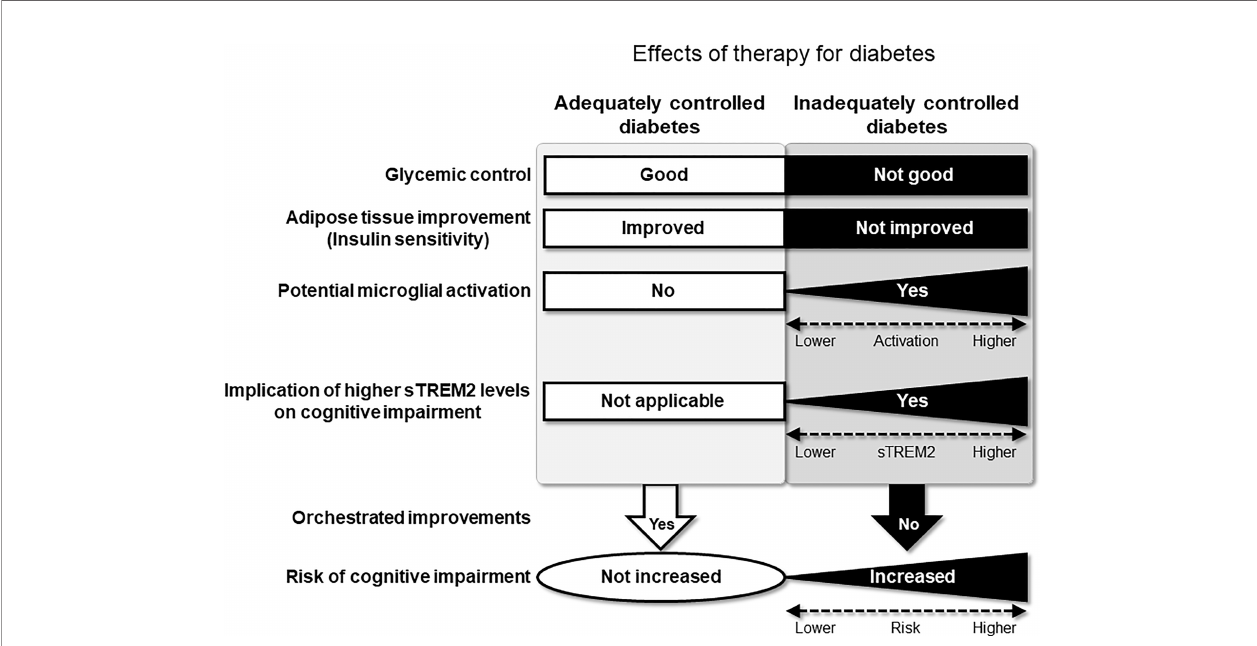
FIGURE 3 | Hypothetical pathological relationships exist between sTREM2 levels, diabetes-related parameters, and cognitive impairment in patients with type 2 diabetes without obesity. Effective therapy for diabetes will allow the orchestrated improvement of risk factors for cognitive impairment. Conversely, in inadequately controlled type 2 diabetes without obesity, sTREM2 derived from the adipose tissue as well as hyperglycemia will activate microglia. The activated microglia can subsequently produce sTREM2, leading to an increased risk of cognitive